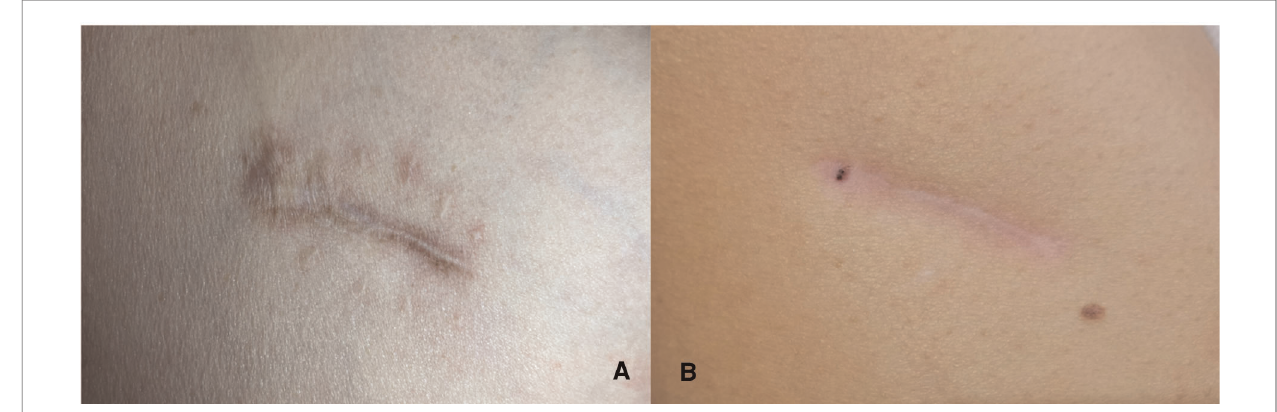
FIGURE 3 | ( A ) Healing status of the wound with the conventional method 6 months after the operation; ( B ) Statement of the wound with our modi fi ed method 6 months after